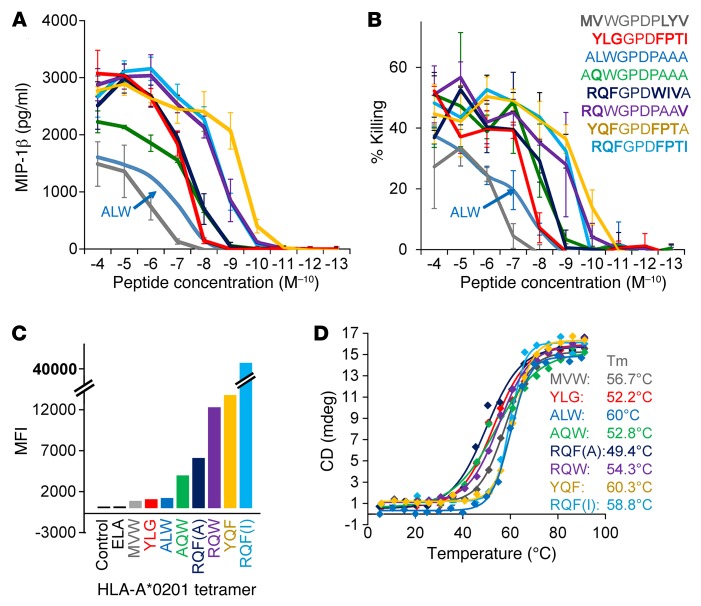
The 1E6 T cell clone reacts with a broad sensitivity range to APLs.(A and B) The 1E6 T cell clone was tested in a peptide dilution assay, in triplicate, with MVWGPDPLYV (gray), YLGGPDFPTI (red), ALWGPDPAAA (blue), AQWGPDPAAA (green), RQFGPDWIVA (dark blue), RQWGPDPAAV (purple), YQFGPDFPTA (yellow), and RQFGPDFPTI (cyan) peptides presented by HLA-A*0201–expressing C1R cells for release of MIP-1β (A) and killing (B). (C) The 1E6 T cell clone was stained, in duplicate, with tetramers composed of each APL (colored as above) presented by HLA-A*0201. (D) The stability of each APL (colored as above) was tested, in duplicate, using CD by recording the peak at 218 nm absorbance from 5°C–90°C. Tm values were calculated using a Boltzmann fit to each set of data.